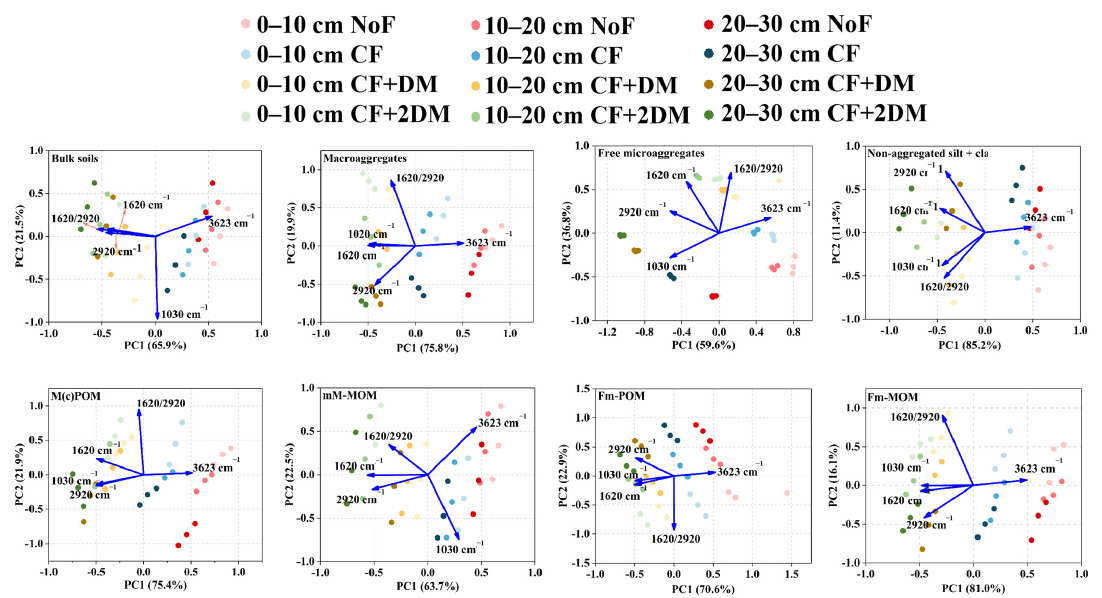
Figure 6. Principal component analysis from the relative absorption peak area and ratio of functional groups by FTIR technology. NoF, non-fertilizer. CF, only chemical fertilizer. CF + DM, chemical fertilizer plus with single dairy manure. CF + 2DM, chemical fertilizer plus with double dairy manure. The specific meanings of organic matter fractions with abbreviations are presented in Table 1.